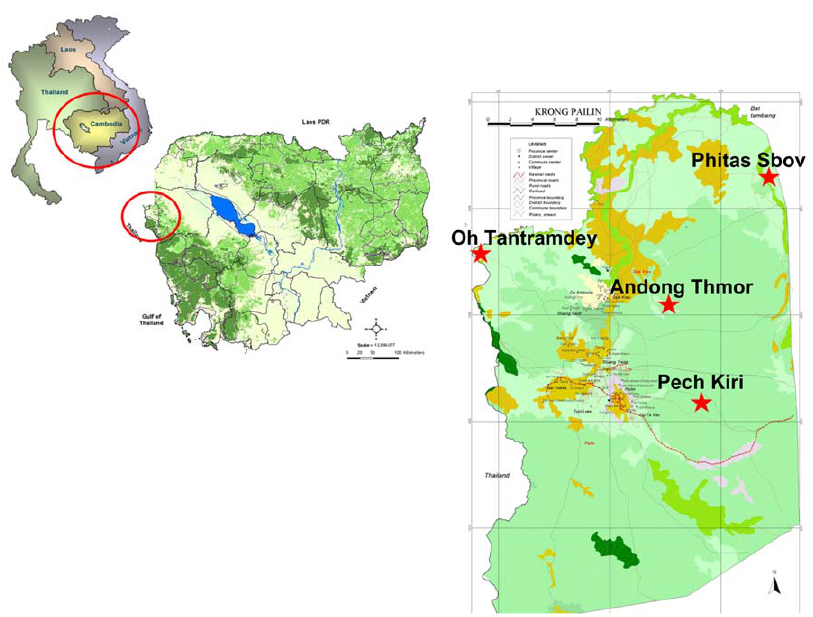
Figure 1. Map of Cambodia locating the four selected villages in Pailin province, Cambodia, 2010.